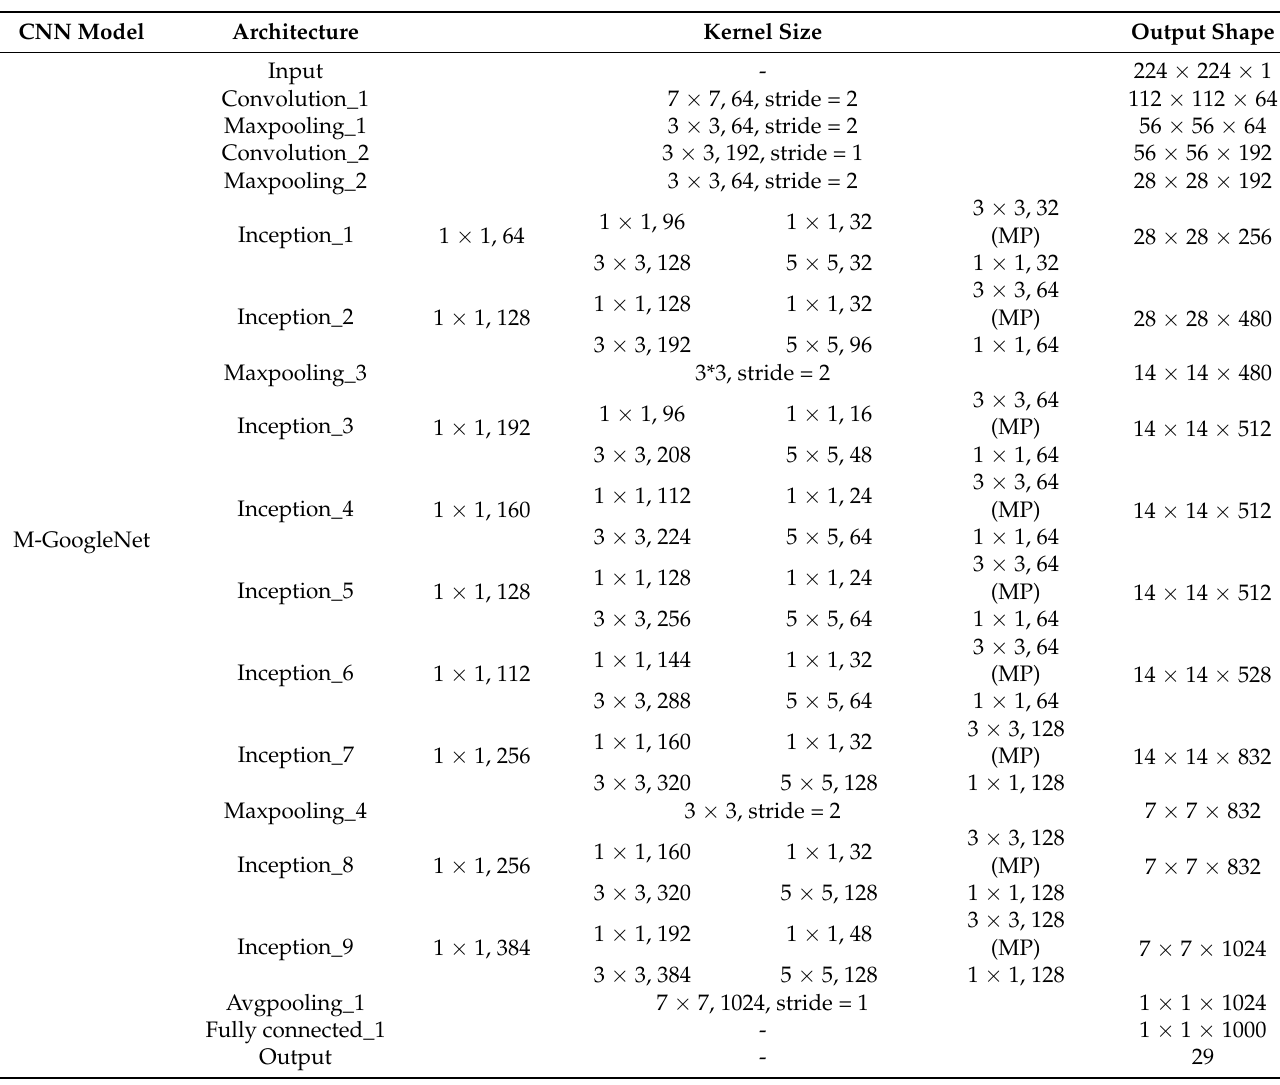
Table 3. The architecture of M-GoogleNet.